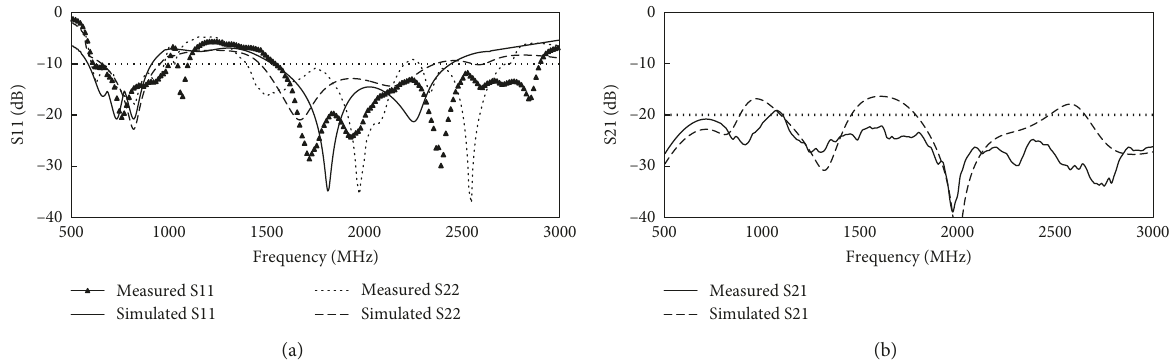
Figure 2: Simulated and measured results of proposed antenna. (a) S11 (dB) against frequency. (b) S21 (dB) against